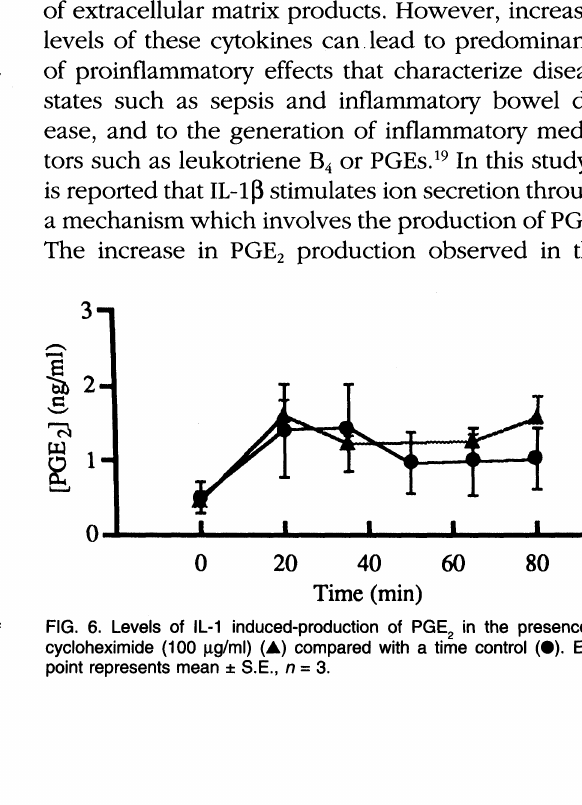
FIG. 4. The effect of IL-I on the production of PGE (,) as a function of time, compared with a time control (O). Each point represents mean +/- S.E., n 6, *p < 0.05.